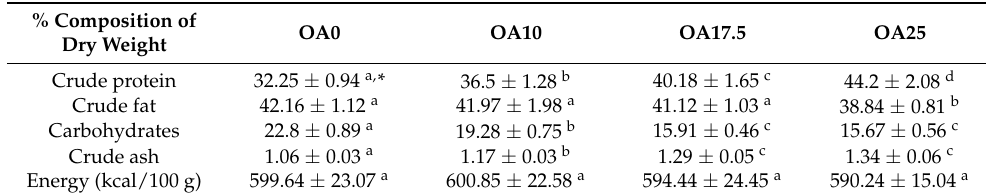
Table 2. Proximate composition of Tenebrio molitor larvae fed for six weeks with wheat bran (control) (OA0) and bran fortified with different rates of albedo orange peel waste (10 (OA10), 17.5 (OA17.5), and 25% (OA25)) (n =